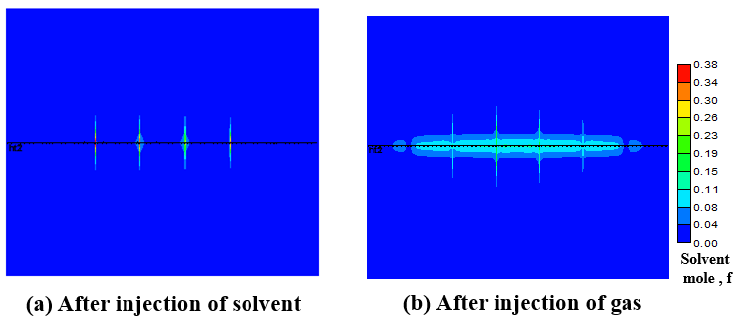
Figure 13. Solvent distribution field at different timings (mole